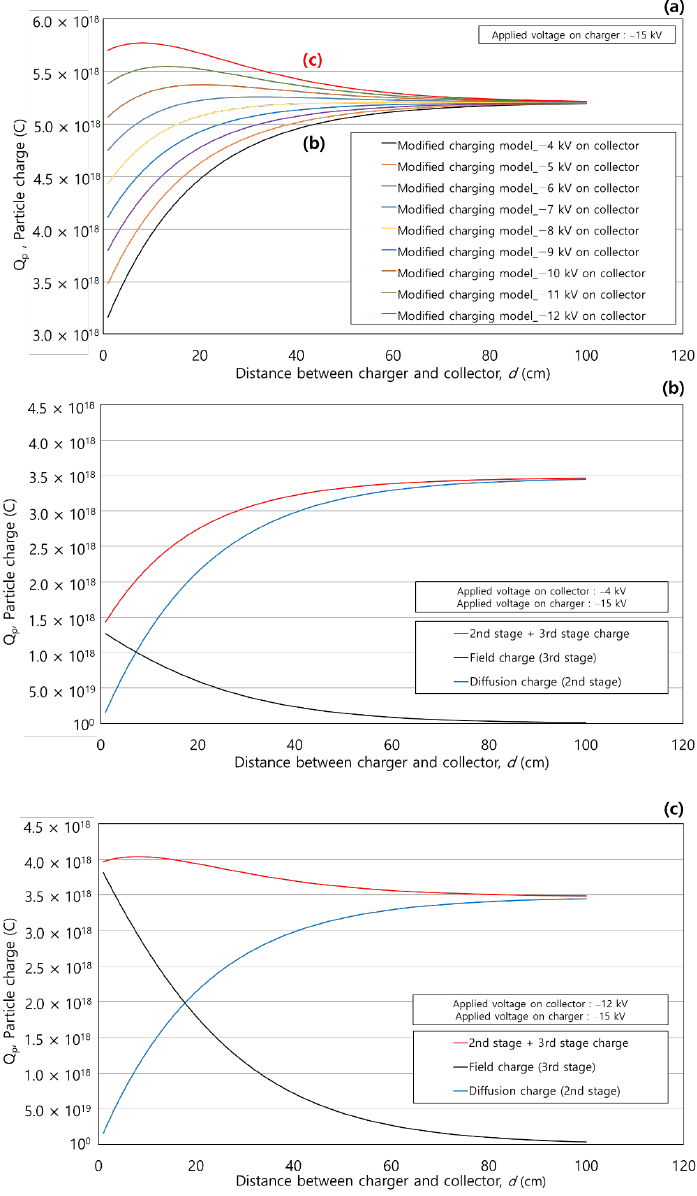
Figure 12. Comparison of the particle charge variances according to the distance between the charger and the collector using the modified charging model: ( a ) Total particle charge according to the applied voltage on the collector ( − 4 kV to − 12 kV); ( b ) Particle charge of the 2nd and 3rd stages with − 4 kV on the collector; ( c ) Particle charge of the 2nd and 3rd stages with − 12 kV on the collector.